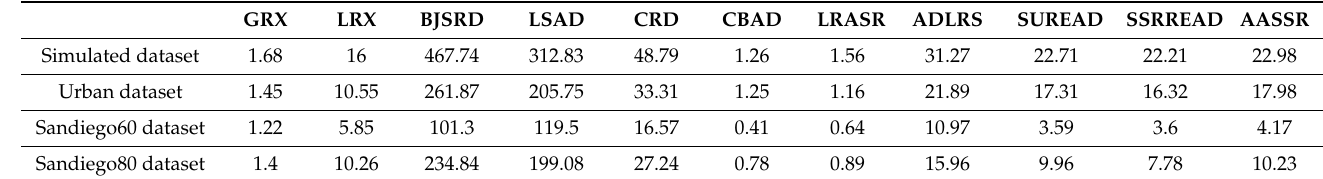
Figure 18. ROC curves and AUC values for the Sandiego80 dataset. Table 1. Running Times (s) of All Methods for All